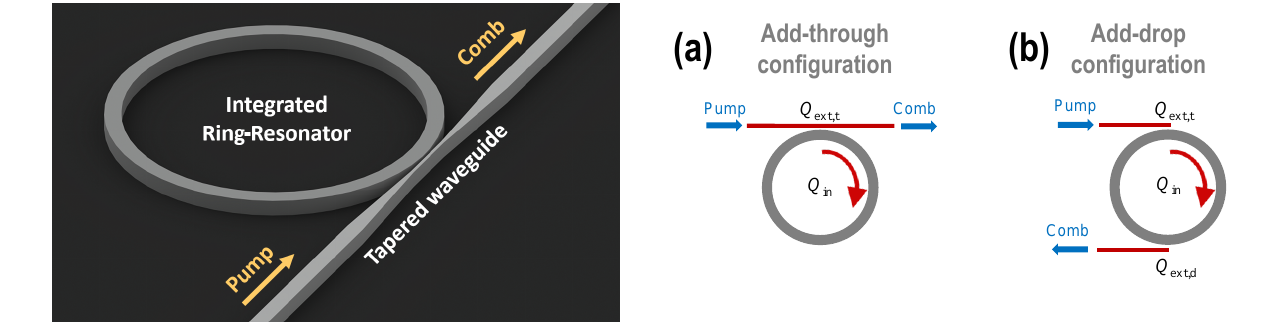
Figure 3: (Color online) An integrated ring-resonator coupled to a tapered waveguide. Such resonators typically have a Q -factor of one million at 1550 nm. The tapered section should typically be thinner than the pump wavelength in order to allow for the evanescent coupling with the resonator.